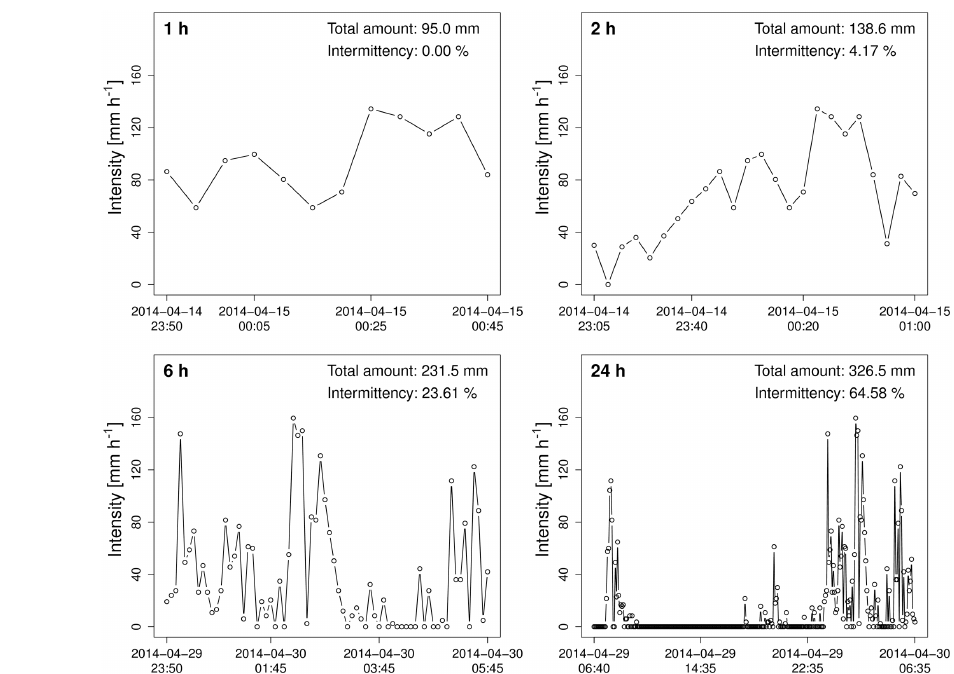
Figure 2. Highest rainfall accumulations recorded at AL-Fairhope-3-NE for 1, 2, 6 and 24h aggregation timescales.